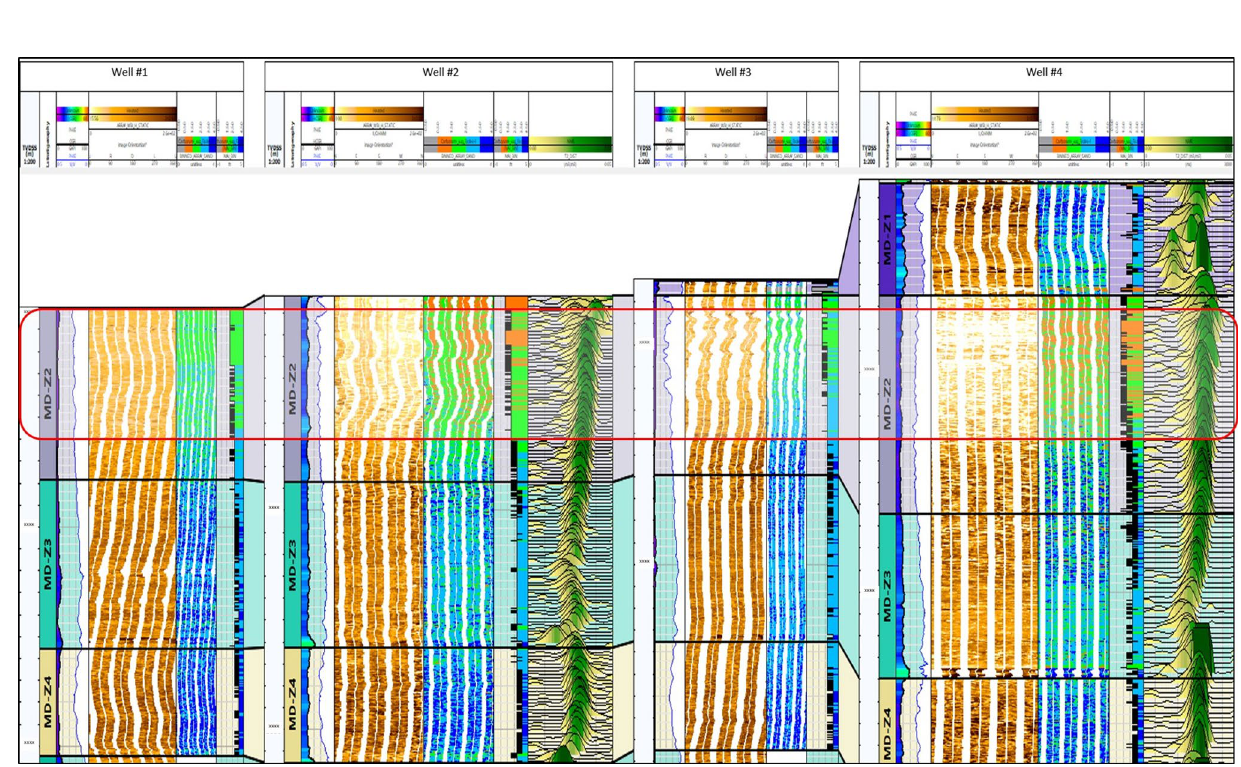
Fig. 5 Facies determination by FMI data in 4 wells in Mauddud Formation; Track 3: GR, Porosity. Track 4: Image Static, Track 5: Facies Image, Track 6: Facies Code. Track 7: T2 Distribution in 2 wells. Red section shows highly vuggy intervals in the Upper part of Mauddud